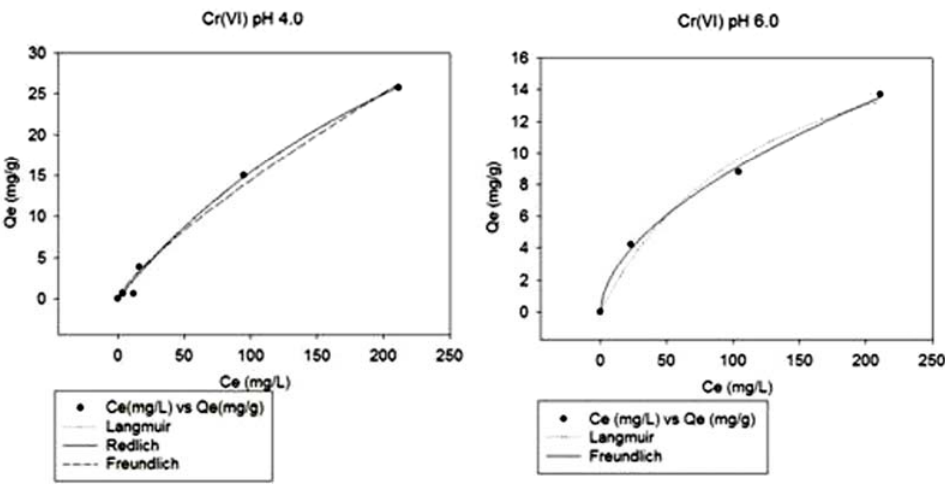
Figure 5. Comparison between experimental data of Cr(VI) adsorption on chitosan/zeolite film and those predicted by the three models tested, at two pH